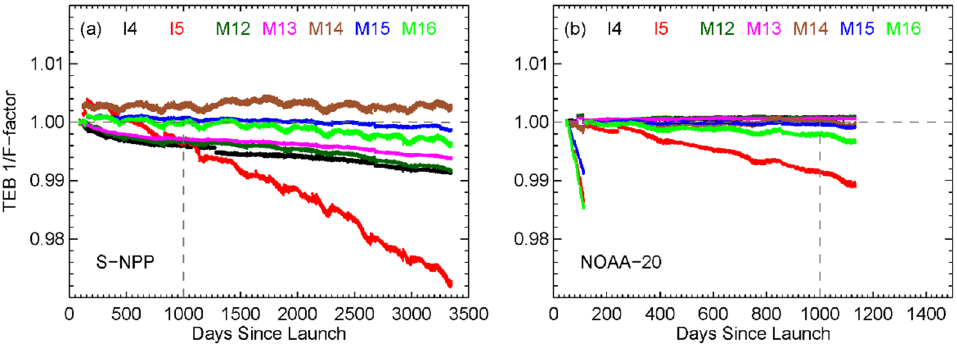
Figure 5. Time series of normalized band-averaged TEB gains (1/F-factors) during nominal operations for S-NPP ( a ) and NOAA-20 ( b ). Each data point represents an orbital averaged value, using sweet-spot granules. The vertical dash lines mark 1000 days since launch.